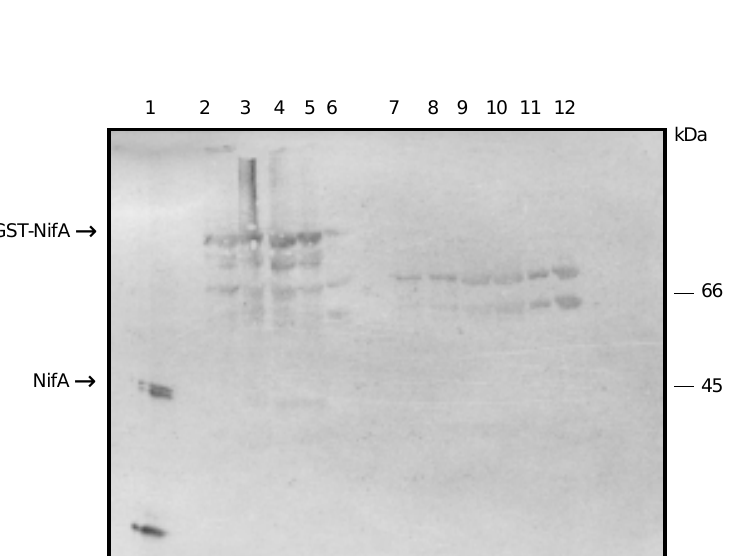
Figure 6 - Immunodetection of the A. brasilense NifA from E. coli cells harboring the pGEXAbA plasmid. Lane 1, partially purified A. brasilense NifA protein; lanes 2-6, E. coli extracts carrying the pGEXAbA plasmid, and lanes 7-12, E. coli extracts carrying pGEXKpA plasmid ( K. pneumoniae GST-NifA fusion